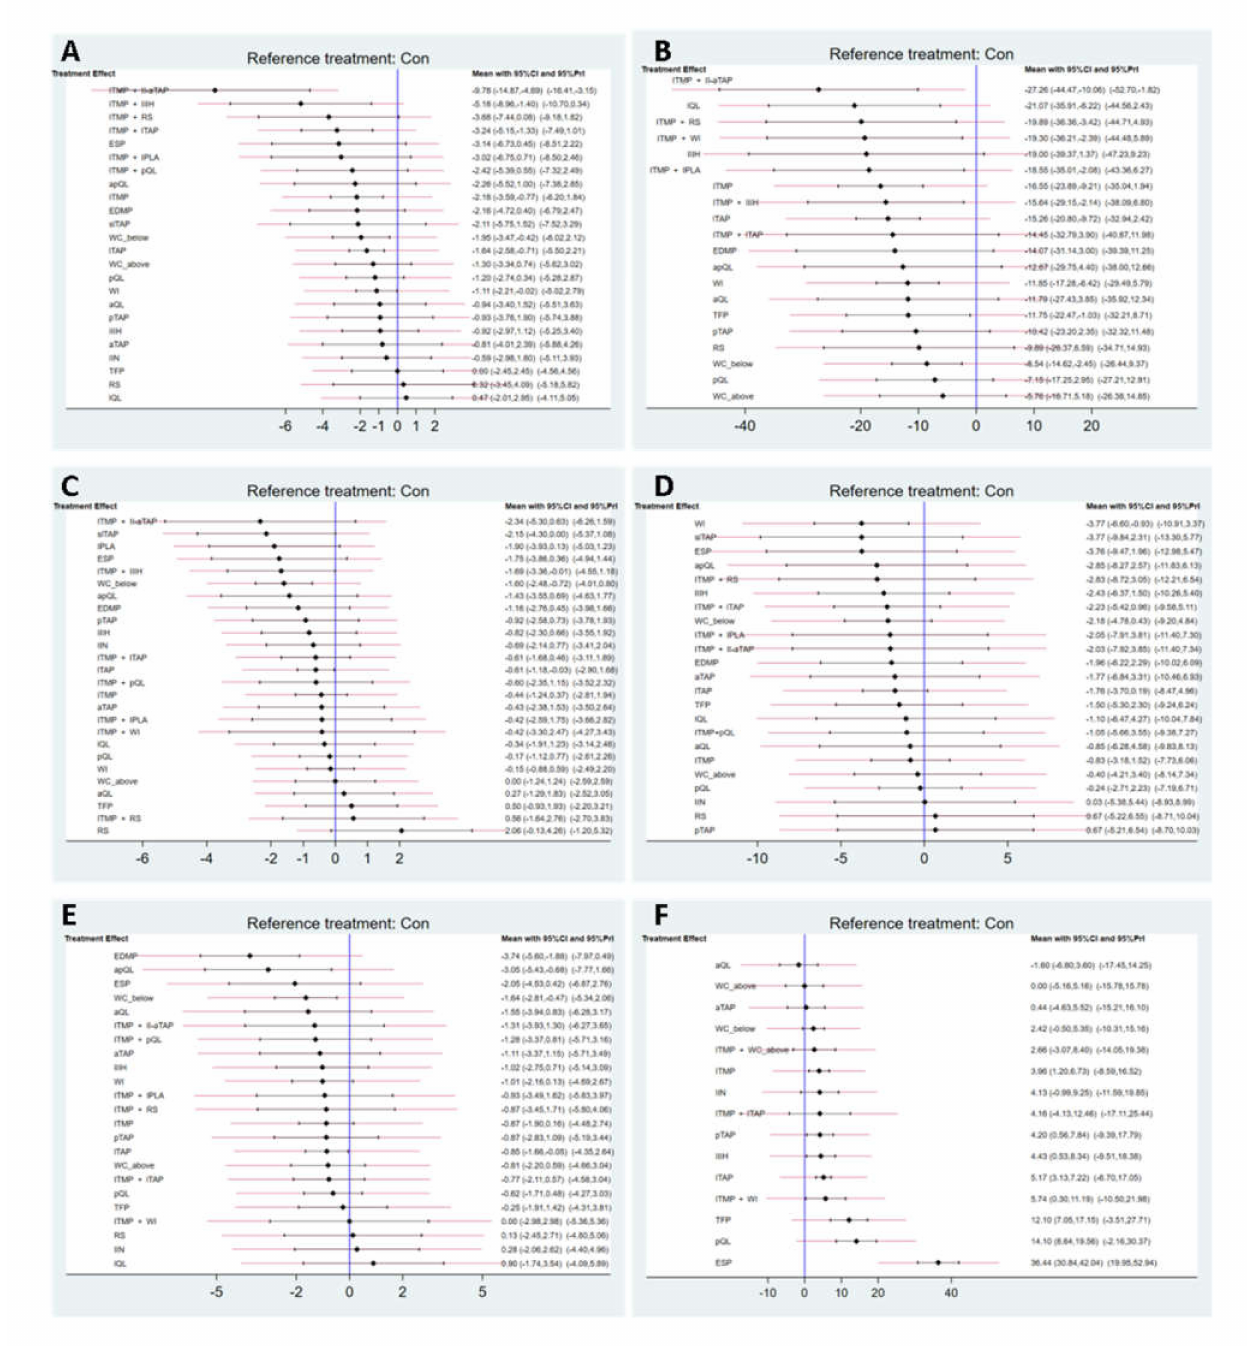
Figure 3. The confidence intervals (CI) and predictive intervals (PrI) of all outcomes. Each solid black line represents the CI for each comparison, and the red one shows the respective PrI. The blue line is the line of no effect (odds ratio = 1). ( A ) Pain at rest 6 h after surgery; ( B ) Postoperative cumulative 24 h morphine equivalent consumption; ( C ) Pain at rest 24 h after surgery; ( D ) Dynamic pain at 6 h after surgery; ( E ) Dynamic pain at 24 h after surgery; ( F ) The time to first analgesic